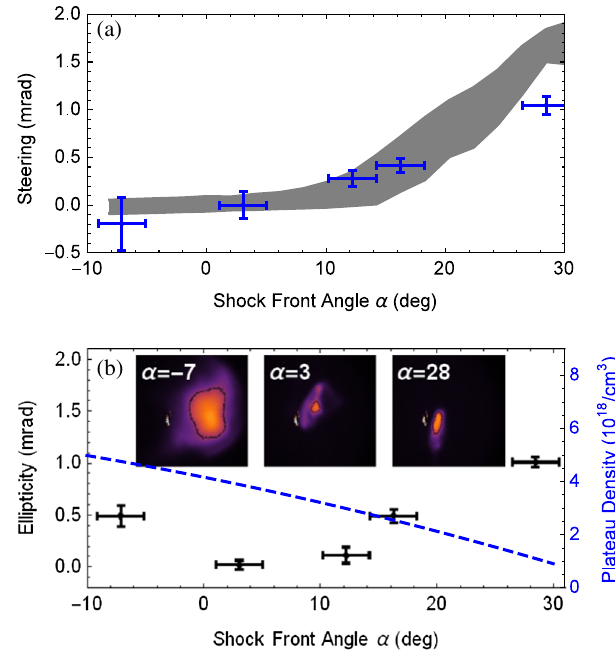
FIG. 4. (a) Steering versus shock front angle. Experimental data on electron beam steering is shown as the blue points while the gray area displays laser refraction calculated from measured density profiles. (b) Ellipticity (black points) and n 2 (dashed line) versus shock front angle. Insets show electron beam spatial profiles for different α .